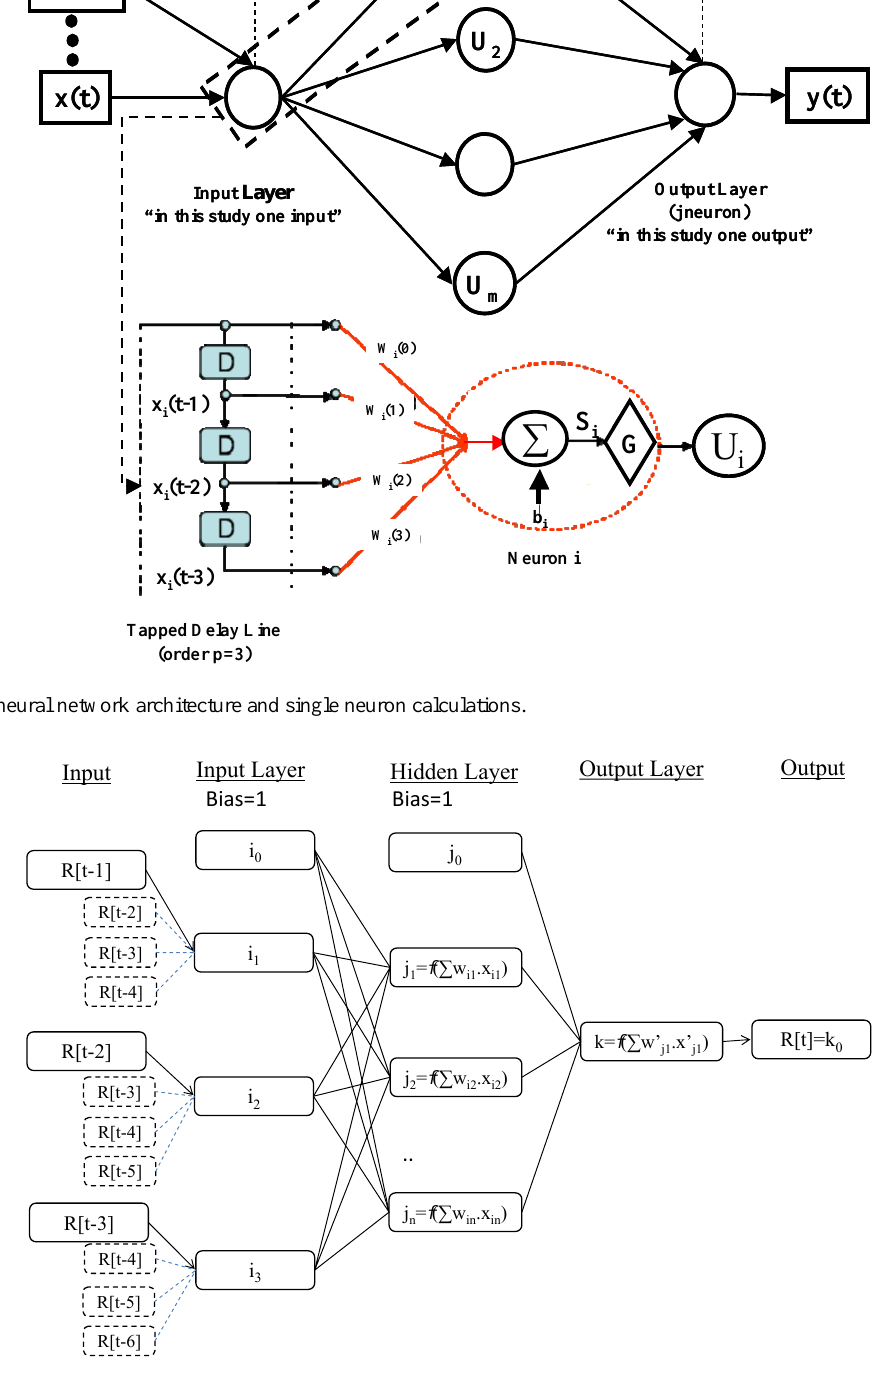
Figure 5 IDNN model architecture Fig. 5. IDNN model